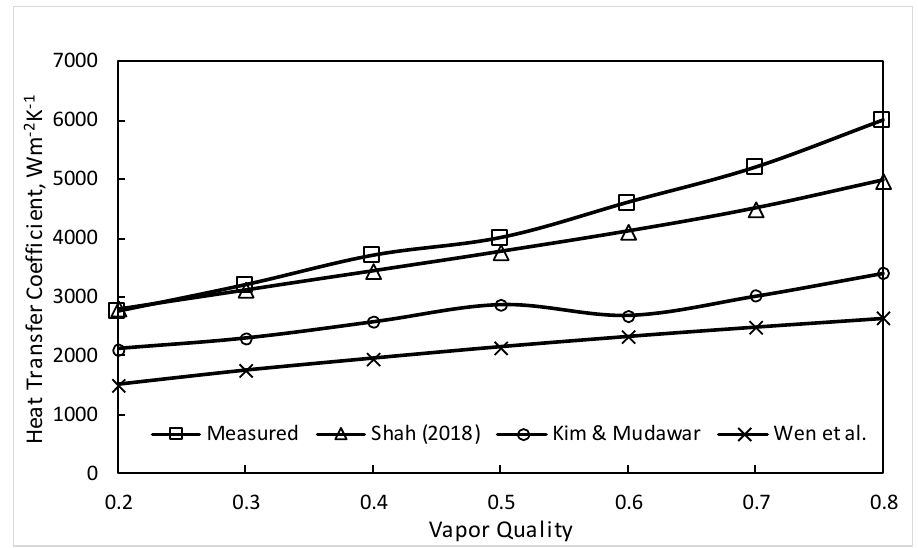
Figure 6. Comparison of the data of Del Col et al. [50] for R-32 in a square channel with various correlations. D HYD = 1.23 mm, G = 100 kgm −2 s −1 , T SAT = 40 C.